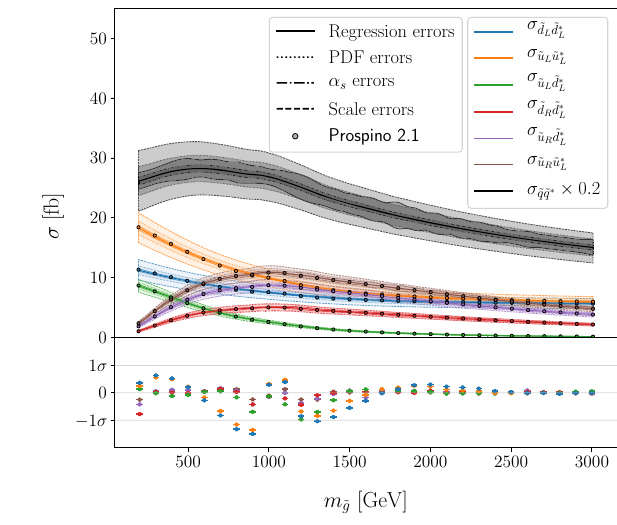
Fig. 13 Squark–anti-squark pair-production cross-sections for first and second-generation squarks. Panels show cross-sections as a func- tion of the average of all first and second-generation squark masses